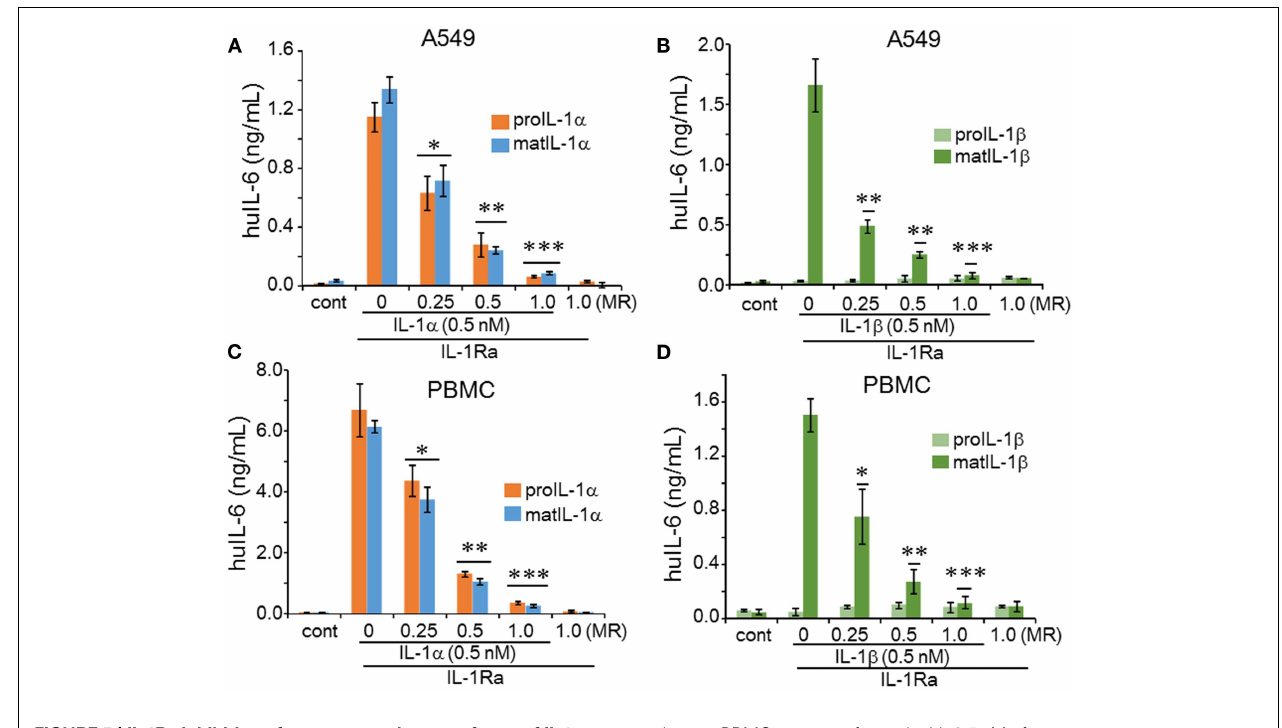
FIGURE 5 | IL-1Ra inhibition of precursor and mature forms of IL-1 α and IL-1 β activity . Prior to stimulation with IL-1 (0.5nM), increasing concentrations of IL-1Ra were added to cells and are indicated as molar excess of IL-1Ra to IL-1 under the horizontal axis as molar ratio (MR). A549 cells were stimulated with 0.5nM of precursor or mature recombinant IL-1 α (A) and 0.5nM of precursor or mature recombinant IL-1 β (B) in the presence of absence of IL-1Ra. Similar experiments of